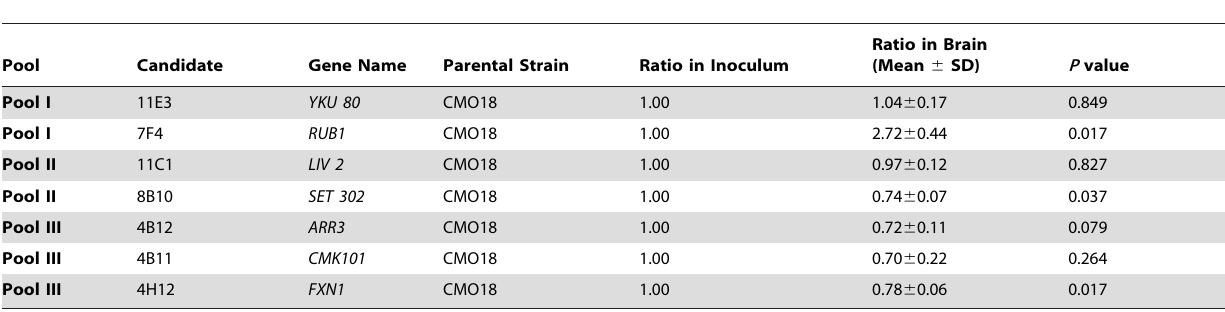
Table 2. The competition ratio of seven STLN3 strains by